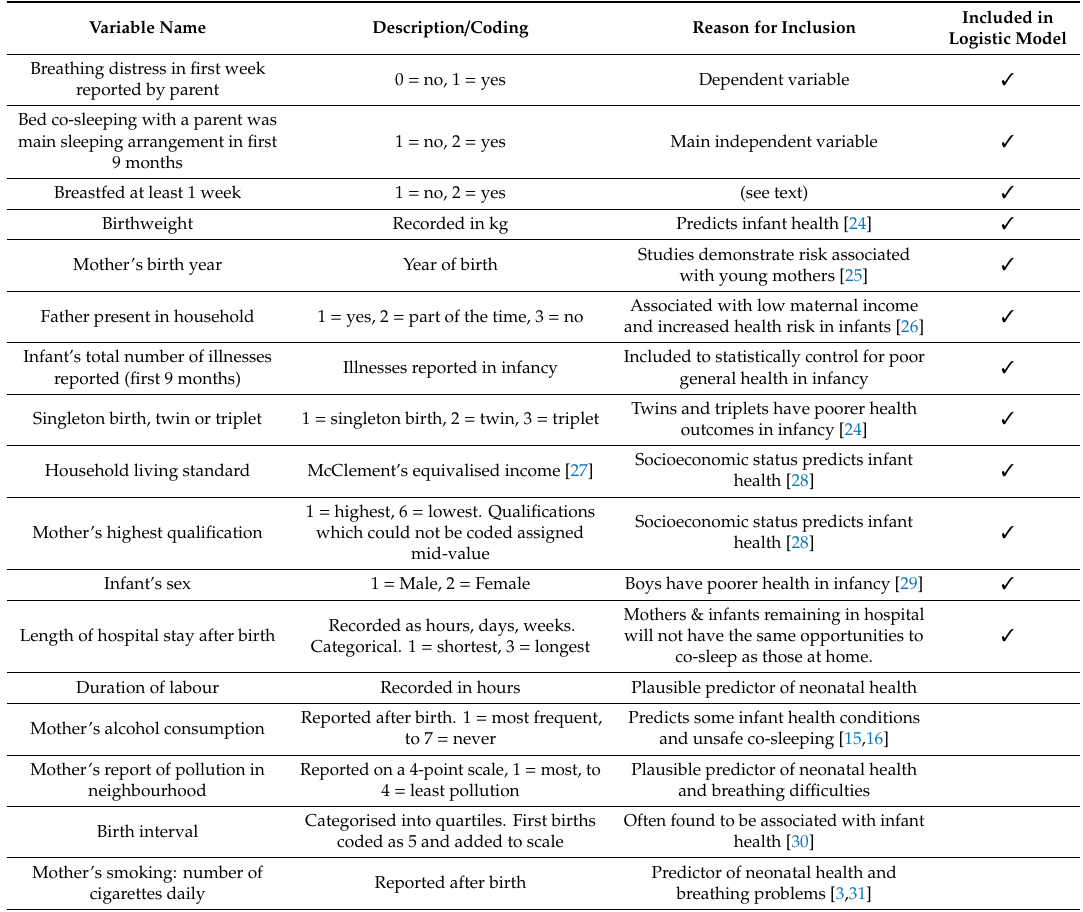
Table 1. MCS variables included in